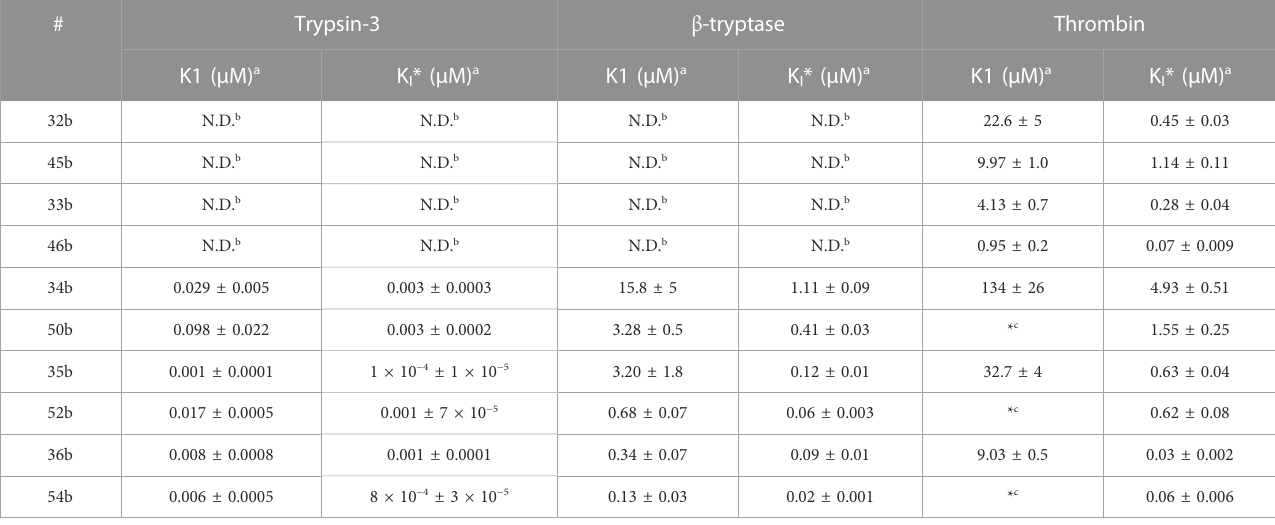
TABLE 5 Apparent equilibrium constants of the fi rst step of slow-binding (K1) and the overall process (K I *) for the reversible probes. # Trypsin-3 β